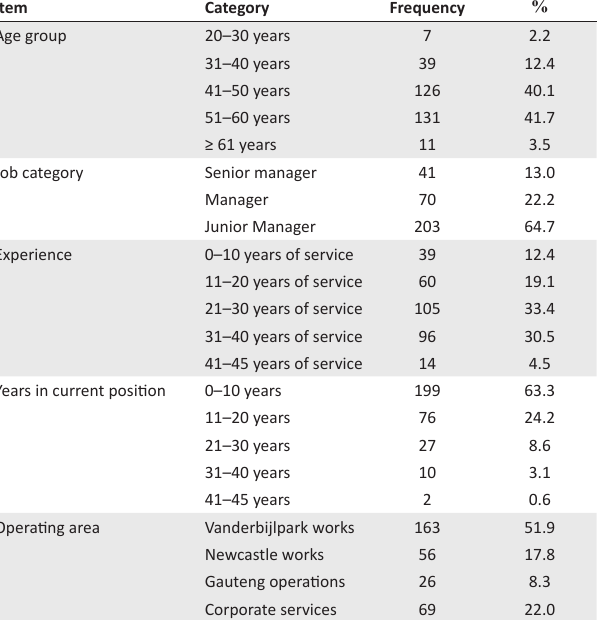
TABLE 1: Characteristics of participants ( n = 314). Item Category